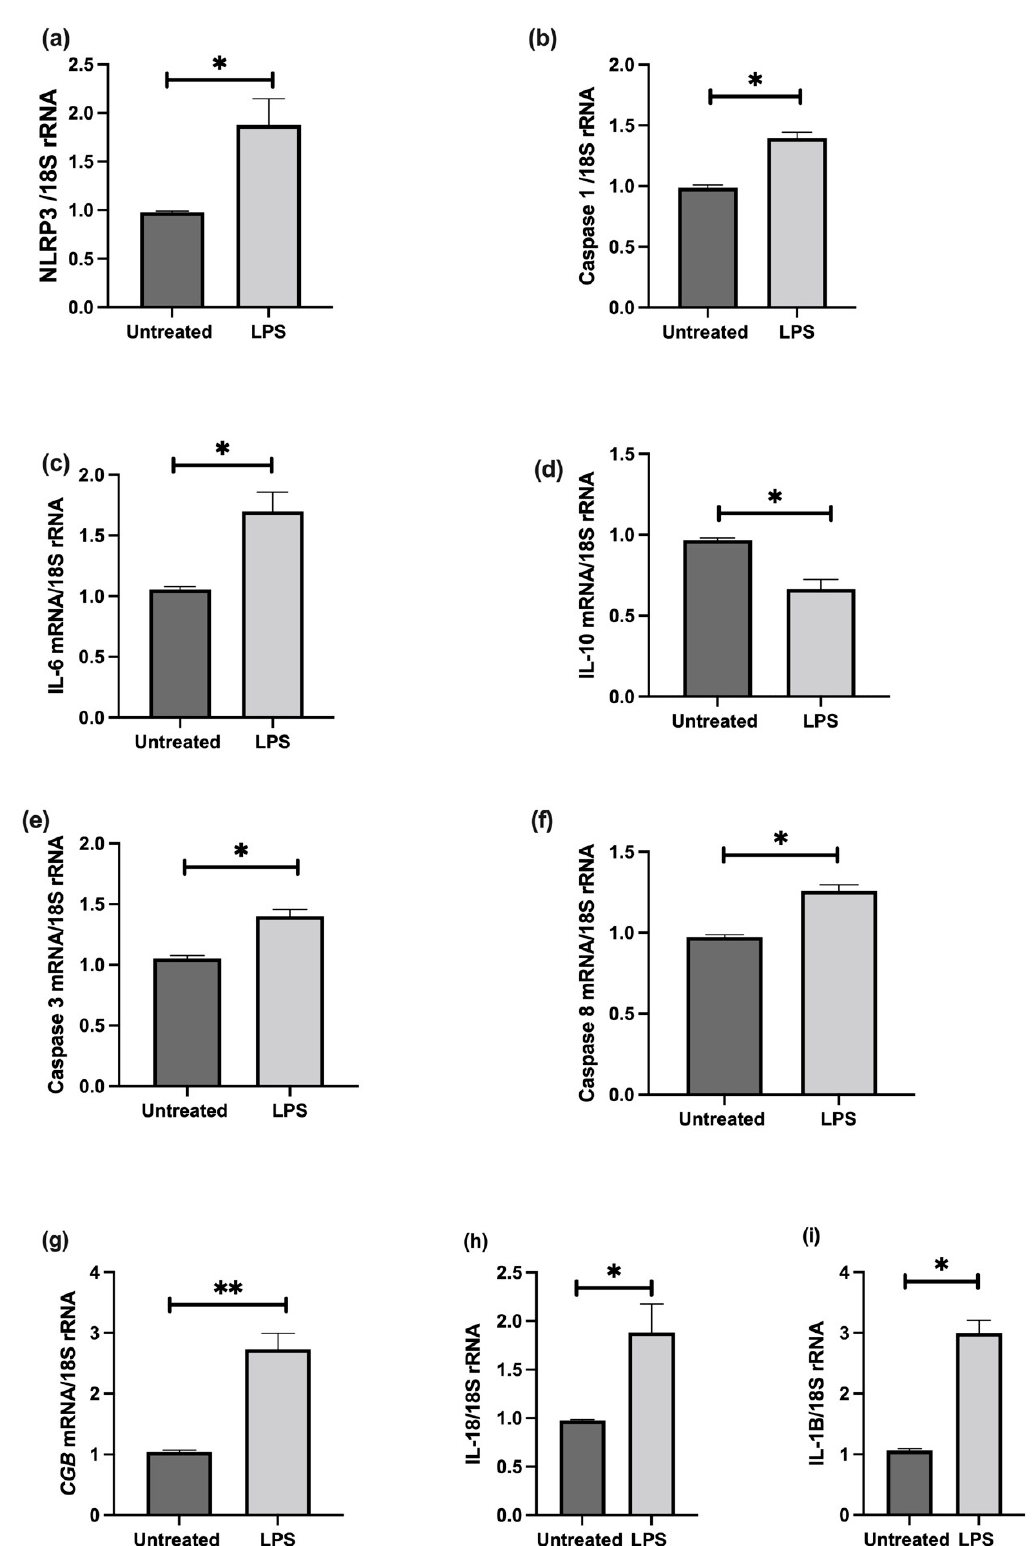
Figure 7. Effect of LPS on BeWo cell function in vitro. Confluent cultures treated in the presence of 1 ng/mL LPS show significant increases in ( a ) NLRP3, ( b ) caspase-1, ( c ) IL-6, ( i ) IL-1 β , ( h ) IL-18, ( g ) CGB, and ( e ) caspase-3 and ( f ) Caspase-8 mRNA, and a significantly decreased ( d ) IL-10 mRNA relative 18S rRNA ( a – i ). Significant differences are denoted by * p < 0.05; ** p < 0.005.